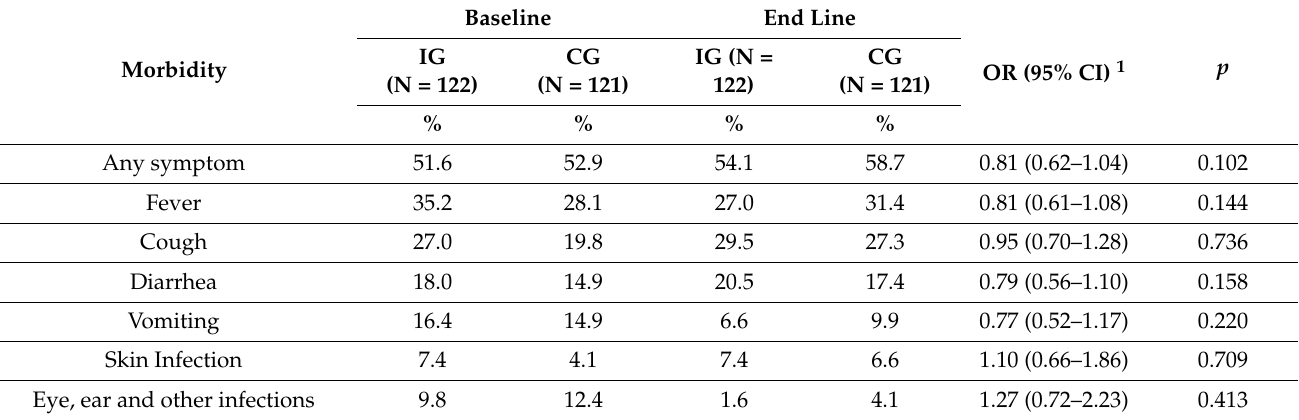
Table 5. Effect of nutrition-sensitive child-owned poultry intervention on the prevalence of morbidity